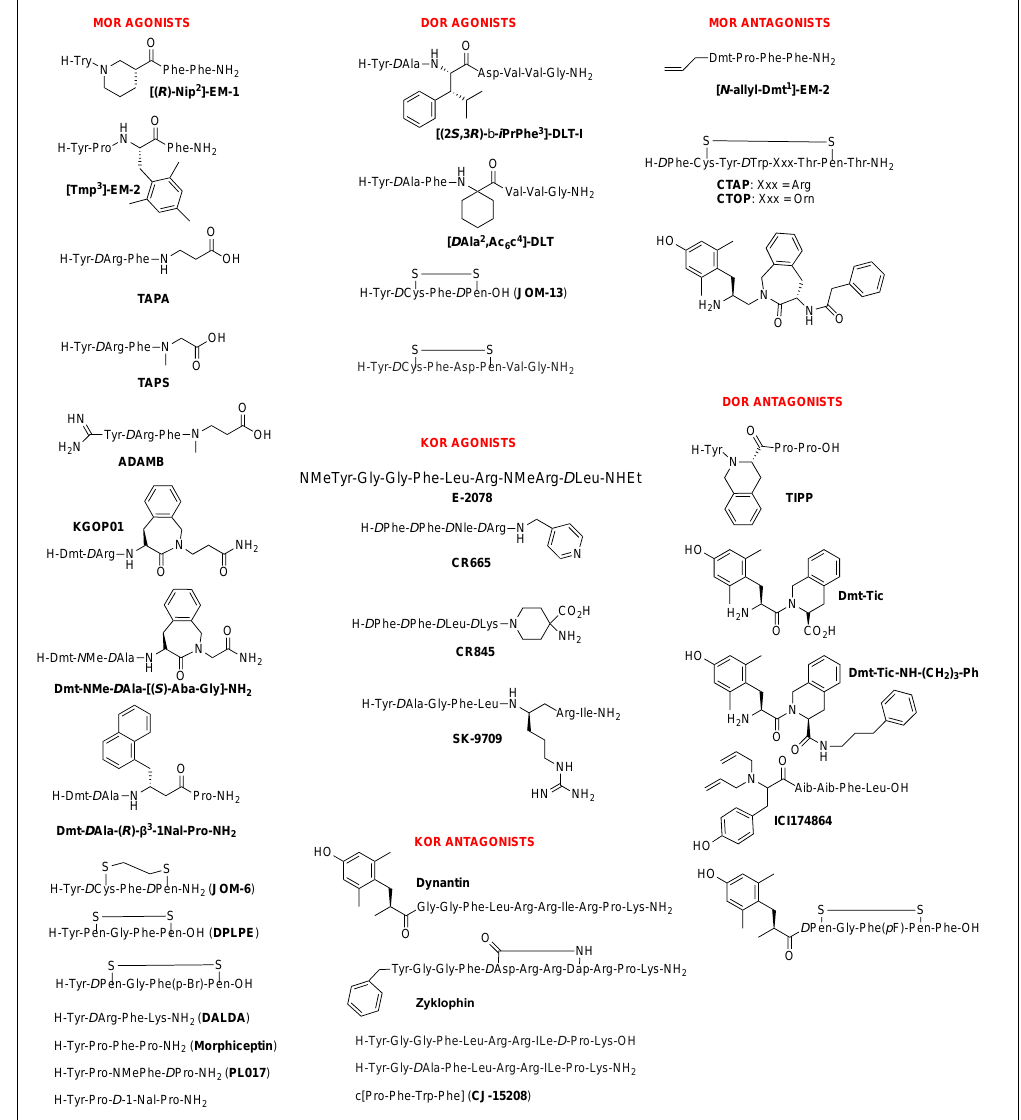
Figure 5. Structures of selective opioid